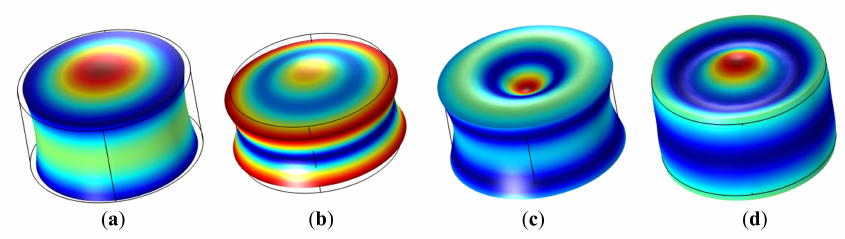
Figure 13. Radial extensional oscillation for PIC ceramic 255. ( a ) first mode 177kHz; ( b ) second mode 270kHz; ( c ) third mode 353kHz; and ( d ) fourth mode